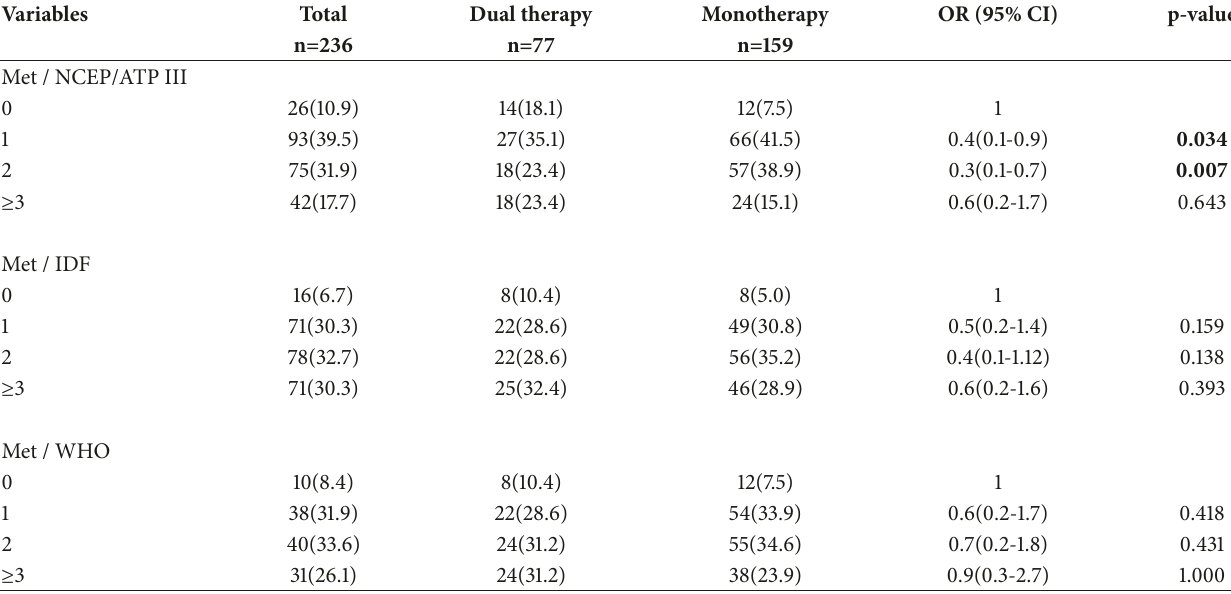
Table 4: MetS among studied subjects on dual and mono antipsychotic